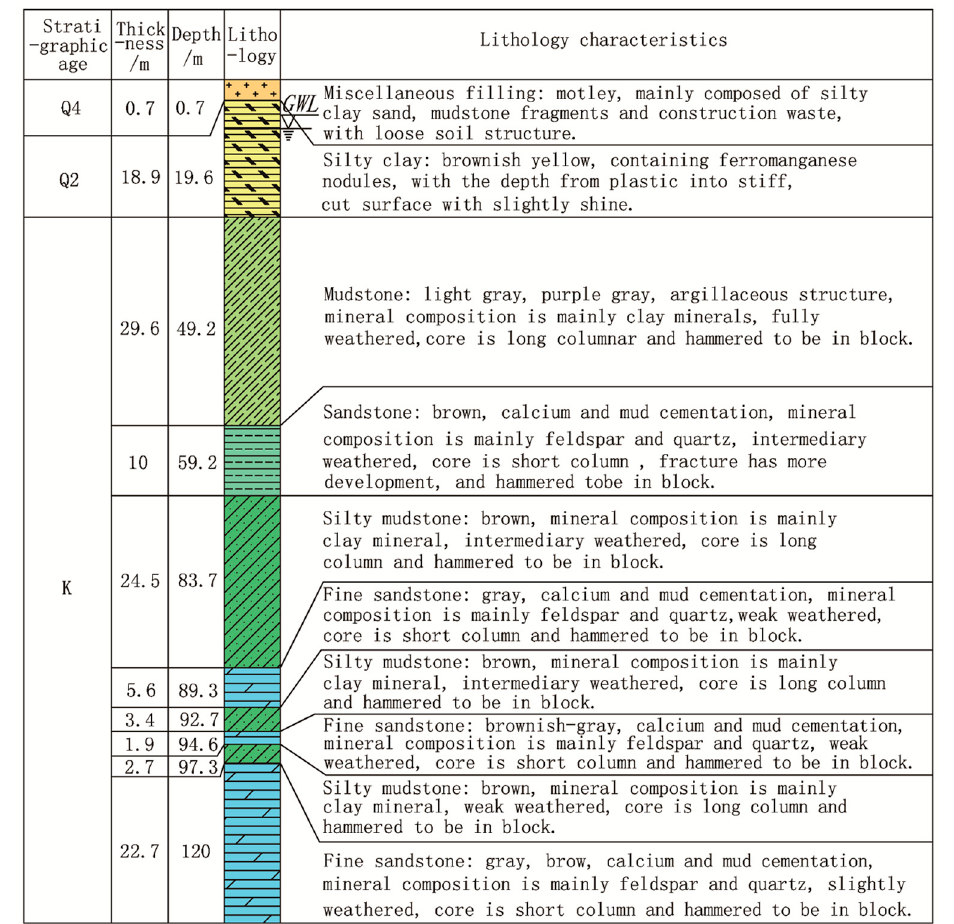
Figure 3. Comprehensive strata log diagram.